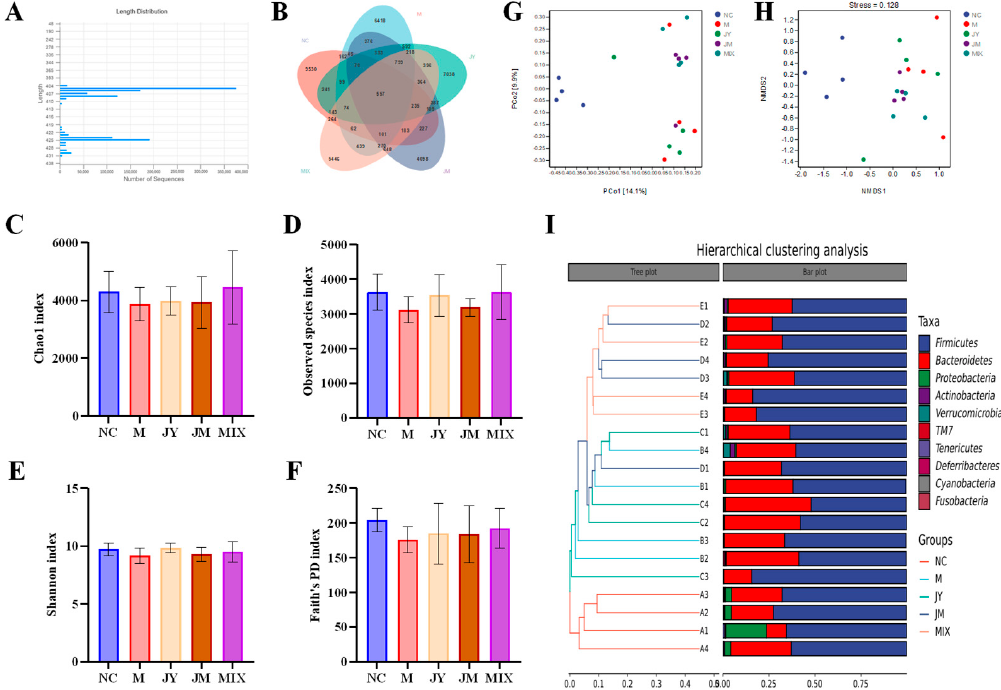
Figure 5. Alpha diversity index and Beta diversity analysis of gut microbiota: ( A ) sequence-length distribution; ( B ) ASV venn diagram; ( C ) Chao1 index; ( D ) Observed species index; ( E ) Shannon in- dex; ( F ) Faith’s PD index; ( G ) principal coordinates analysis (PCoA); ( H ) nonmetric multidimen- sional scaling (NDMS) analysis; ( I ) hierarchical clustering analysis using the unweighted pair-group method with arithmetic means (UPGMA). A stands for the normal control group (NC), B for the model group (M), C for the L. paracasei JY062 group (JY), D for the L. gasseri JM1 group (JM), and E for the combination group (MIX).